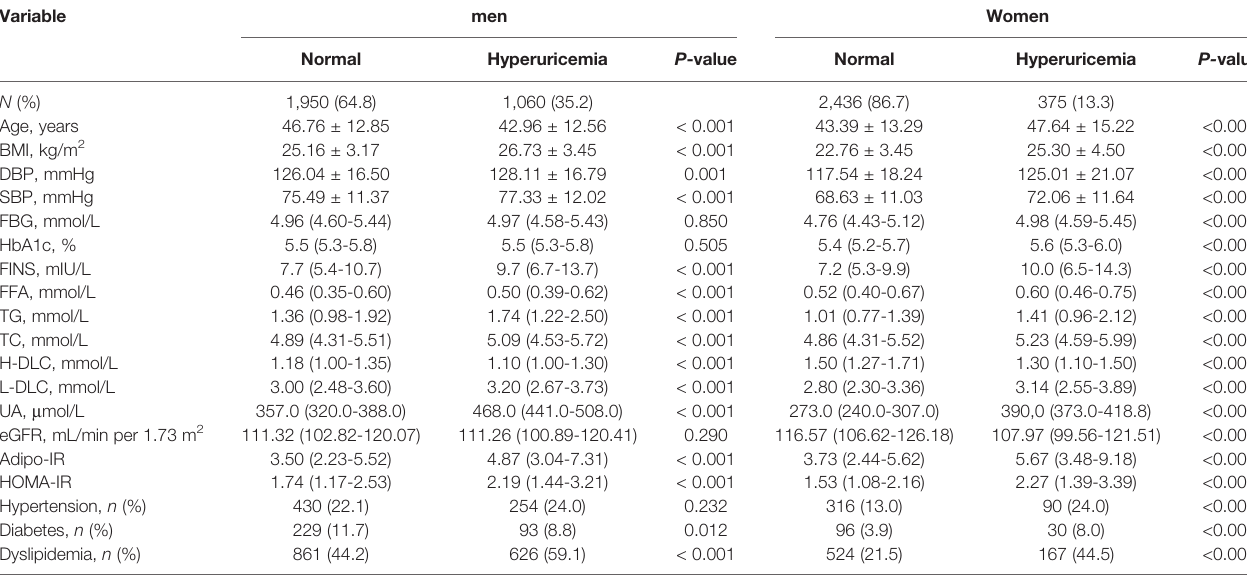
TABLE 1 | Basic characteristics of the participants with and without hyperuricemia. Variable